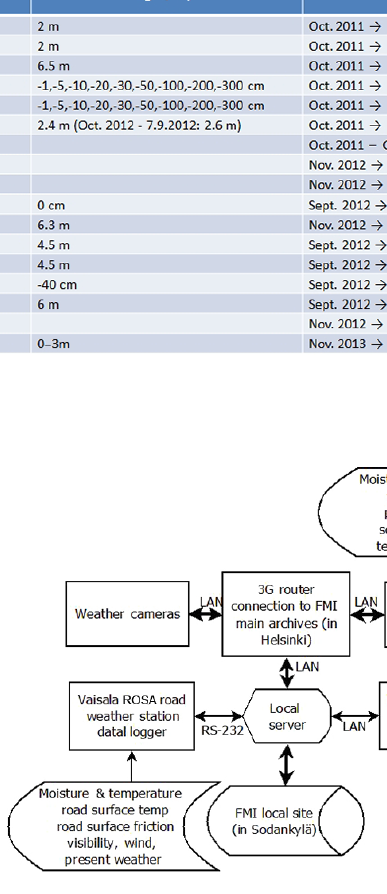
Figure 3. Communication entity of